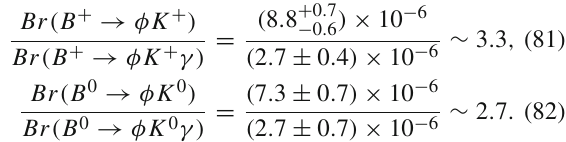
Fig. 6 B s → φ ¯ K 0 γ decay spectrum in the φ K invariant